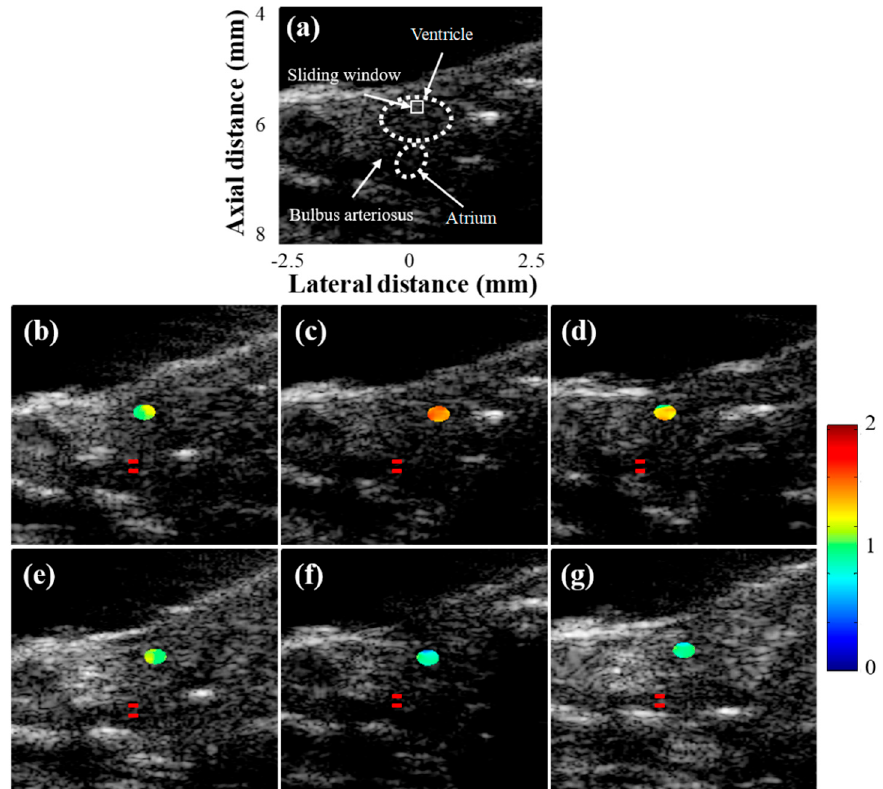
Figure 6. The Nakagami images overlaid on B-mode images acquired from the adult zebrafish ( a ) one week prior to ventricular amputation and ( b ) 3, ( c ) 7, ( d ) 14, ( e ) 21, and ( f ) 32 days post-amputation (dpa). The Nakagami image was only constructed for the amputated regions. The location of the Doppler gates in each image are indicated with red lines.